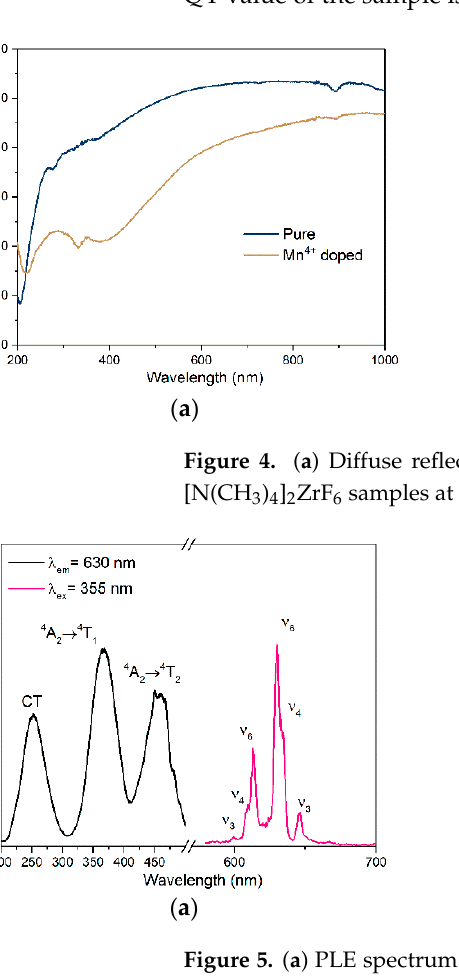
Figure 5. ( a ) PLE spectrum by monitoring at 630 nm, and PL spectrum with excitation of 355 nm of the [N(CH 3 ) 4 ] 2 ZrF 6 :1%Mn 4+ sample at room temperature. ( b ) PLE and PL spectra with abscissa ex- pressed in wavenumbers. As is known, Mn 4+ is a high field ion with 3d 3 configuration, and its luminescence property is highly related to the crystal environment, such as crystal strength, site